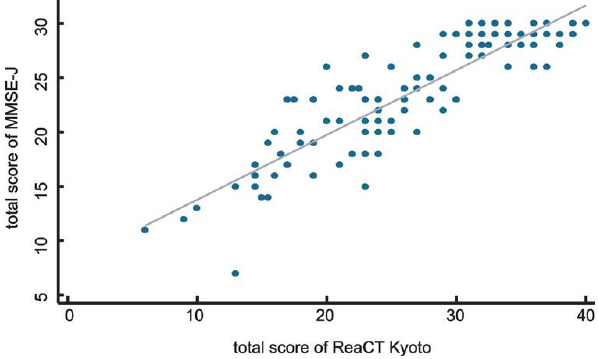
Fig. 2 Correlation analysis between the total scores of the mental health assessment scale for obese children and neuropsychological test